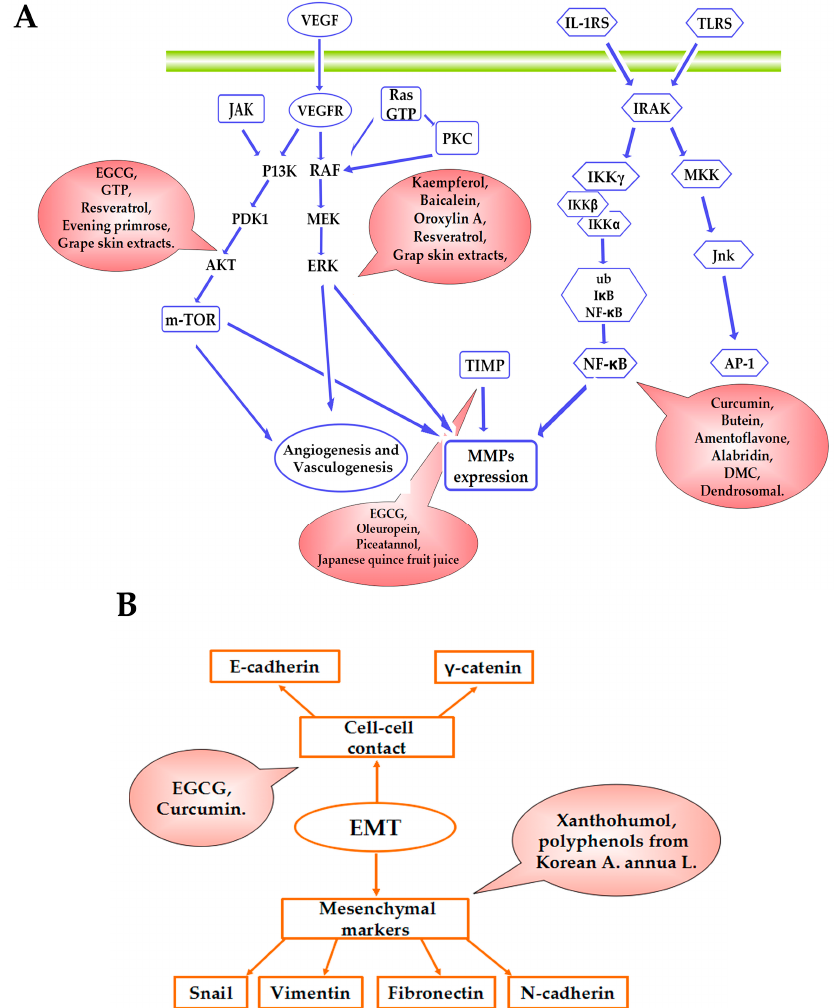
Figure 4. Model for the molecular metchanisms of natural polyphenols effects on metastasis. ( A ) General schematic representation of signalling pathway that regulate MMP-2 and MMP-9 expression, VEGF gene and NF- κ B; ( B ) The proteins that promote cell-cell contact and mesenchymal markers during